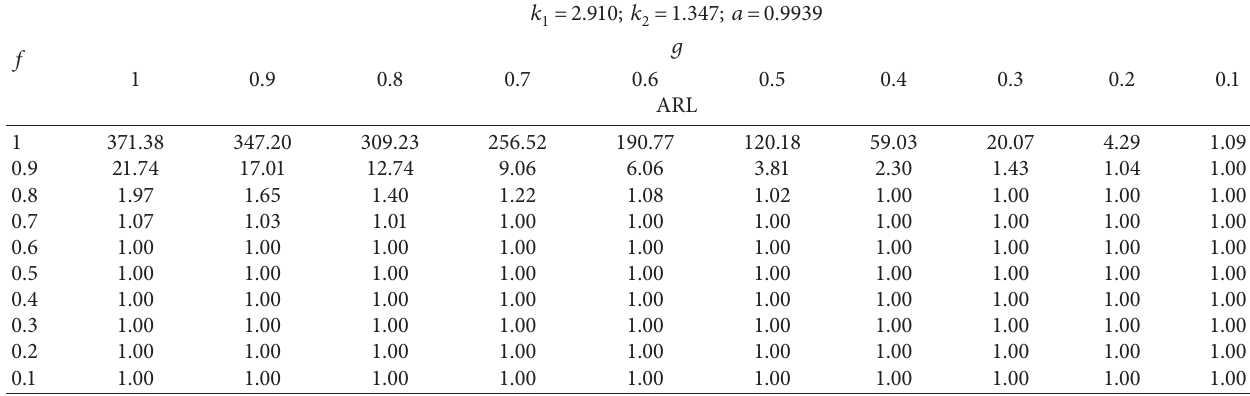
Table 4: The values of ARLs when b � 0.31, n � 20, and i � 4.